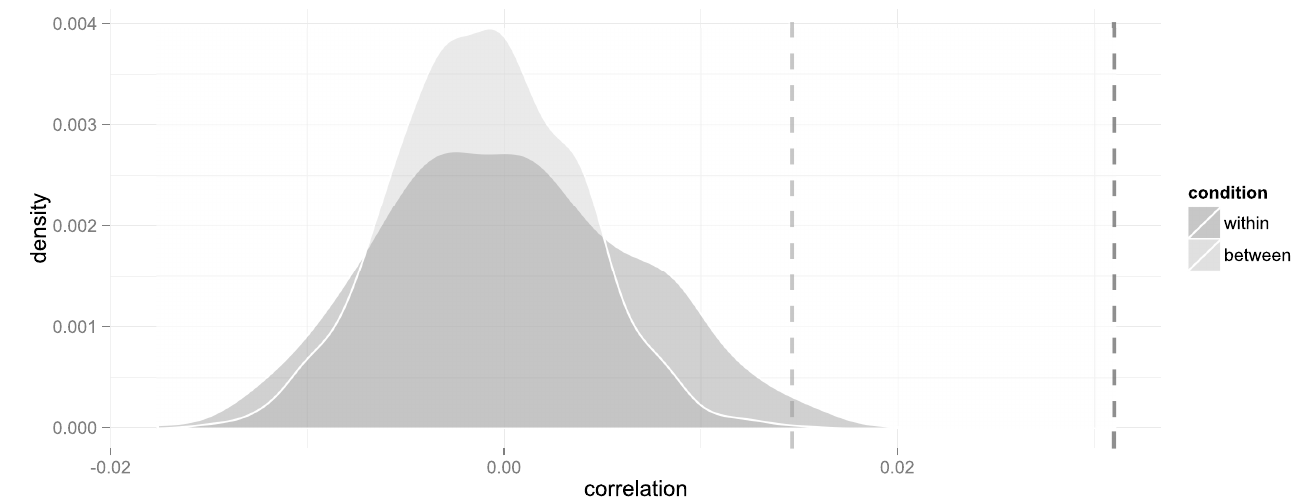
Fig 2. Probability distributions of correlations in the within- and between-group designs under the null hypothesis that choices are randomly allocated irrespective of mother’s country of origin. The dashed lines represent the observed correlations.